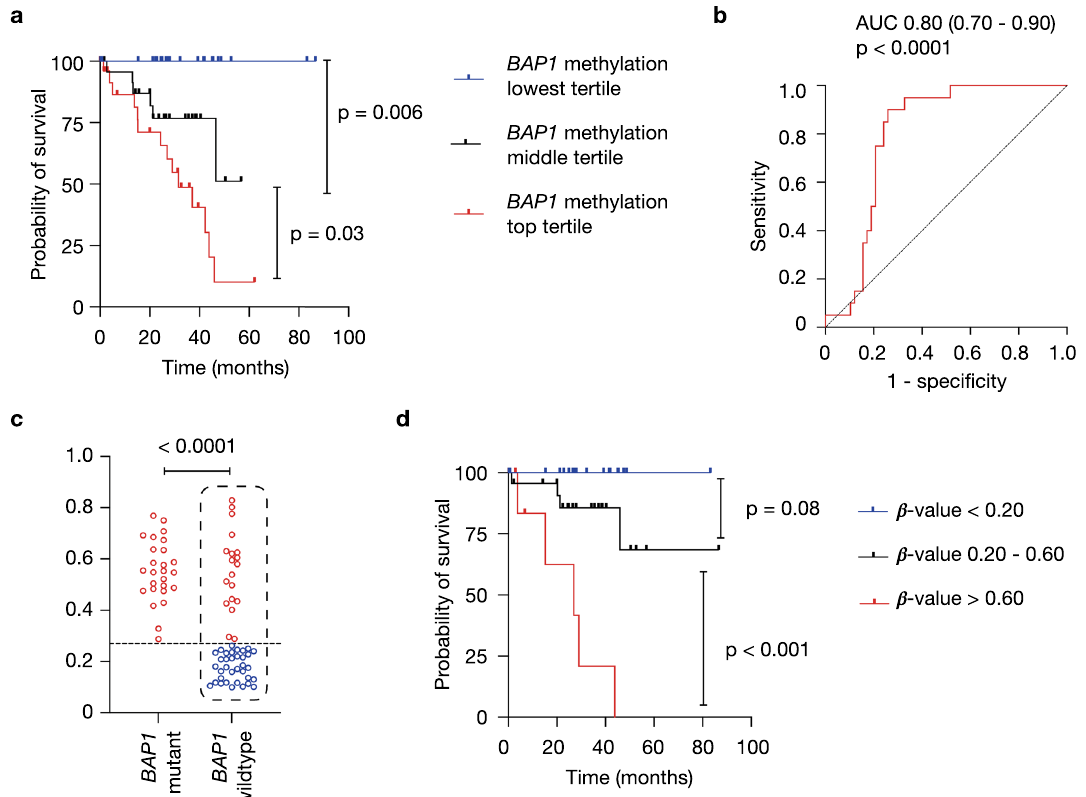
Fig. 2 High BAP1 methylation levels correlate with worse survival. a Probability of survival of ( n = 80) TCGA-UM subjects with primary tumors strati fi ed by BAP1 β -methylation values into three tertiles. Statistical signi fi cance tested using two-sided log-rank test. b ROC curve for the association between BAP1 methylation and death. The reference line for random prediction is shown (dotted). AUC, area under the ROC curve, with 95% con fi dence intervals. c BAP1 methylation levels in BAP1 -mutant ( n = 26) and BAP1-wildtype ( n = 54) UM tumors, as identi fi ed by whole-exome sequencing (data accessed from cbioportal 14,15 ). Statistical signi fi cance tested using two-sided Student ’ s t test. A dotted horizontal line at BAP1 β -methylation value of 0.27 is shown. d Probability of survival of TCGA-UM subjects with BAP1 -wildtype tumors (shown in dotted box in C, n = 54) with primary tumors strati fi ed by their BAP1 β -methylation values lower ( n = 35) and higher ( n = 19) than 0.27, shown in blue and red, respectively. Statistical signi fi cance tested using two-sided log-rank